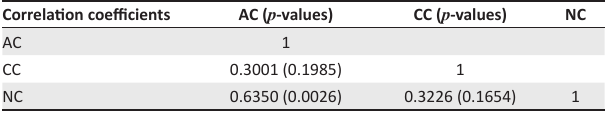
TABLE 7: Pearson’s correlation coefficients and associated p -values for the OCQ instrument. Correlation coefficients